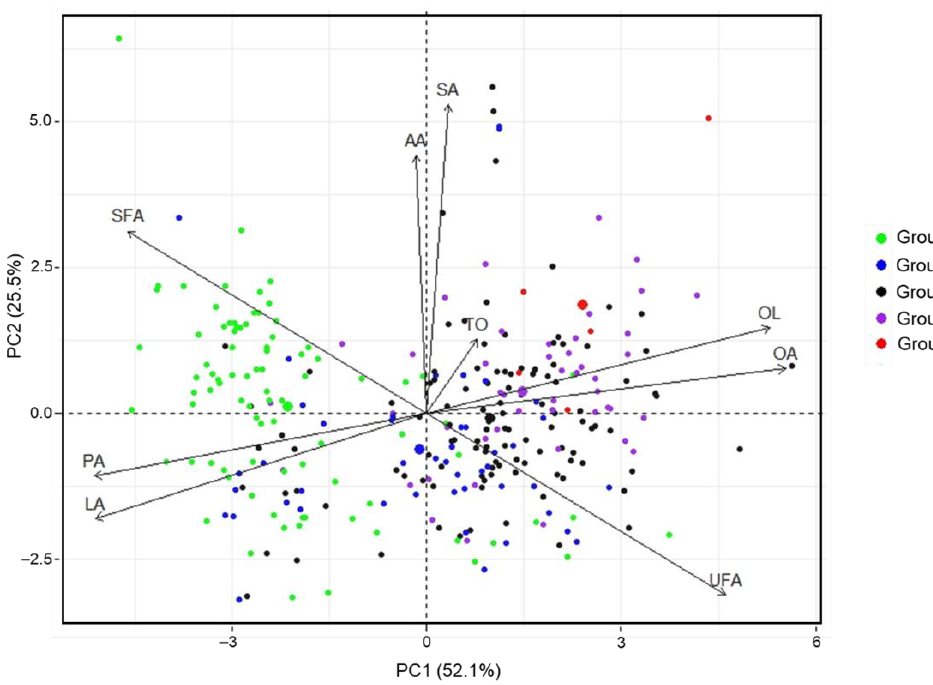
Figure 2. Principal component biplot for peanut accessions of the total oil content, and individual and total fatty acid contents, based on the entire dataset. Group I, Group II, Group III, Group IV, and Group V represent the genotypes have a 100-SW of 25–45 g, 45–65 g, 65–85 g, 85–105 g, and 105–125 g, respectively. TO = total oil, PA = palmitic acid, SA = stearic acid, OA = oleic acid, LA = linoleic acid, AA = arachidic acid, OL = oleic acid to linoleic acid ratio, SFA = total saturated fatty acid, UFA = total unsaturated fatty acid.